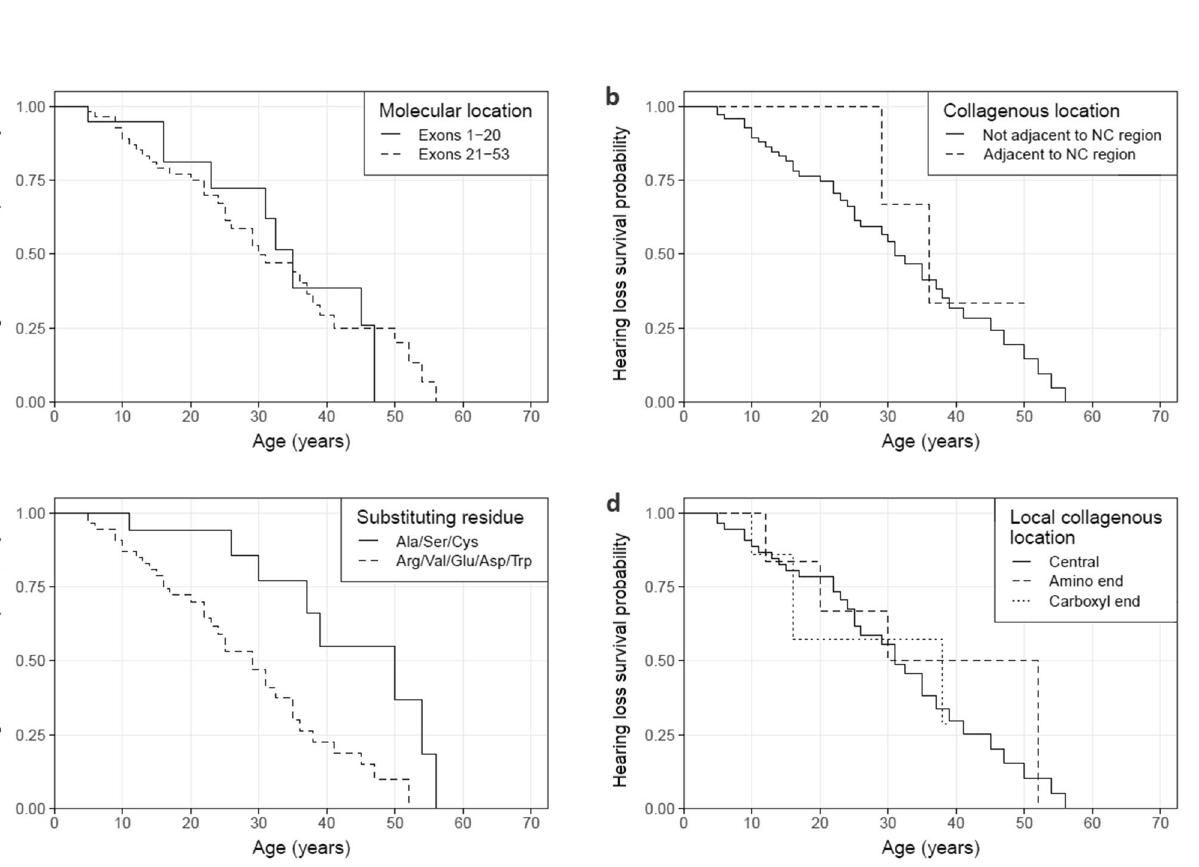
Figure 4. Proportion of cases without a hearing loss diagnosis for COL4A5 Gly missense variants reported in LOVD. Variants were stratified by ( a ) molecular location (p = 0.85), ( b ) collagenous location (p = 0.38) and ( c ) substituting residue (p = 0.004). ( d ) Excluding variants affecting NC boundary residues, variants were further stratified by relative location within their local collagenous region (p = 0.77). Censored data points are not shown. NC,